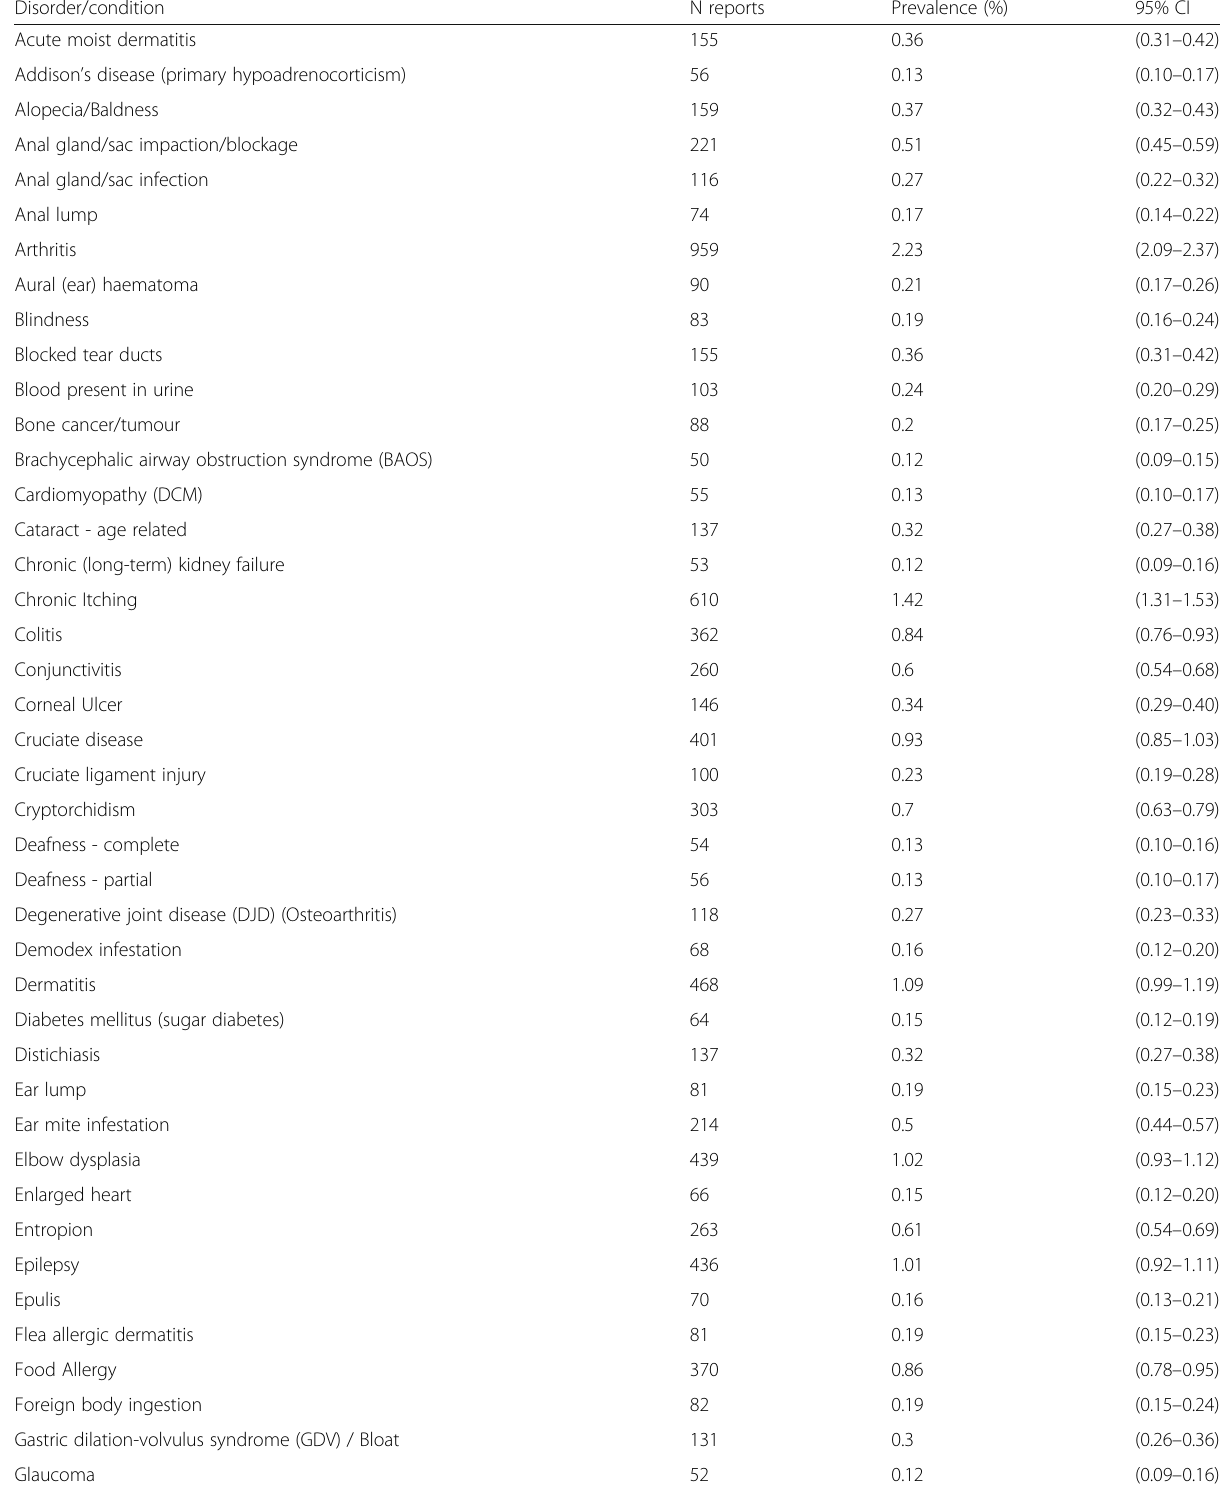
Table 3 List of number of reports and overall prevalence of the most commonly reported conditions/diseases (with ≥ 50 reports in unique live dogs, n =